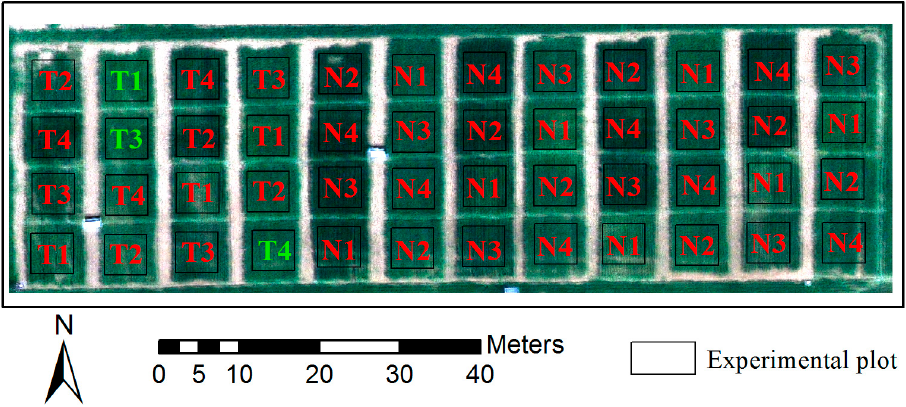
Figure 1. Sketch map of experimental area . The image was taken on 1 May 2017 using Dajiang’s S1000